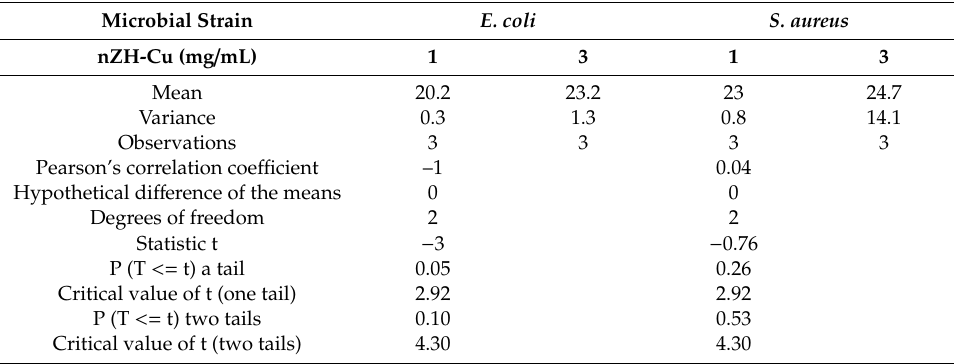
Table 3. t -test for the means of two paired samples.